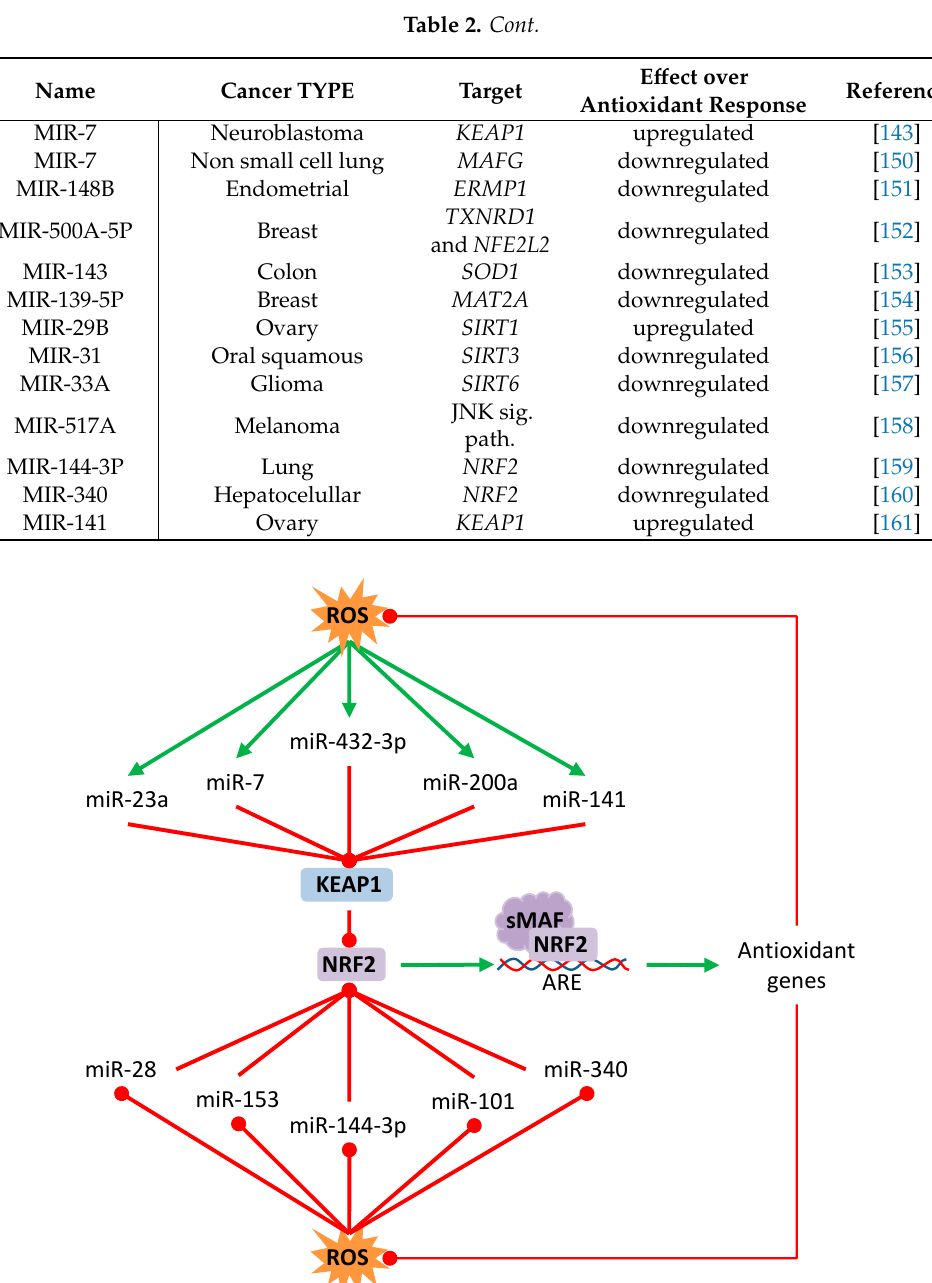
Figure 1. Regulation of NRF2 / Keap1 by microRNAs. Oxidative stress can induce or repress some microRNAs that regulate the posttranscriptional expression of Keap1 or NRF2. Red lines with rounded end indicate inhibition. Green arrows indicate activation.